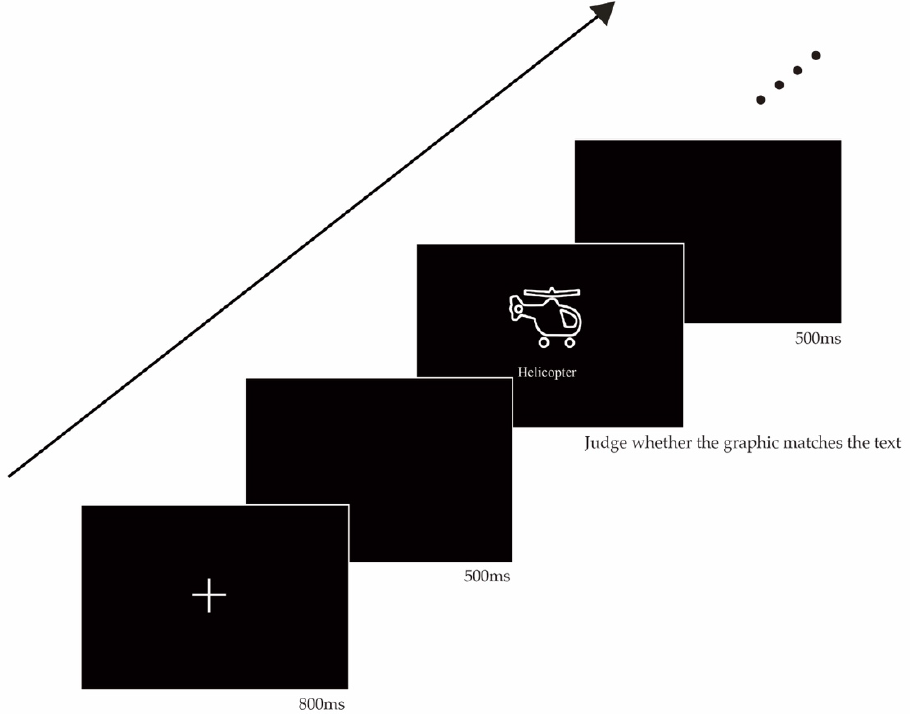
Figure 2. Schematic of the experimental process.